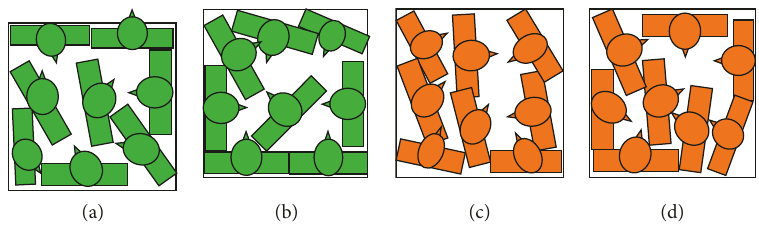
Figure 8: 8 p/m 2 , green: remaining silent, orange: speaking, door at the